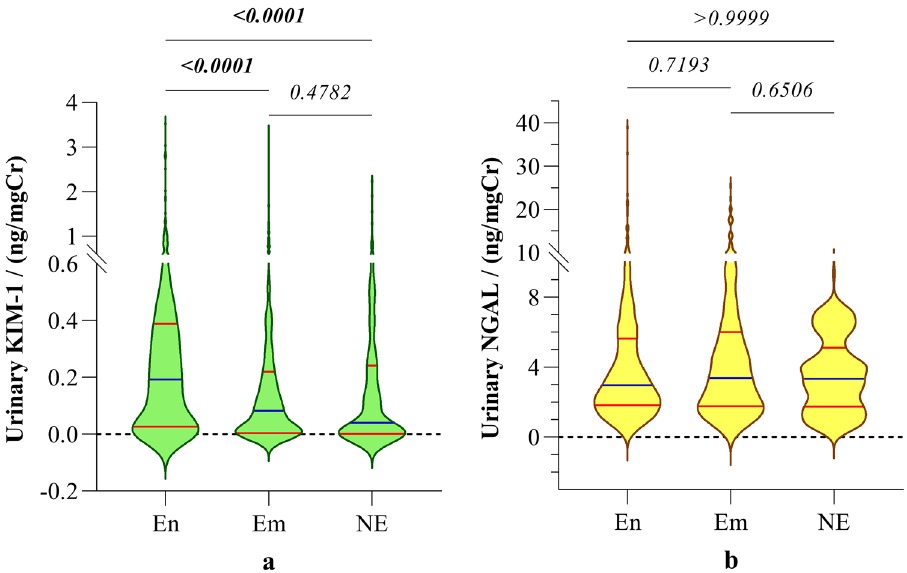
Figure 2. Distribution of urinary biomarkers ( a ) KIM-1 and ( b ) NGAL in children from CKDu endemic, emerging and non-endemic regions irrespective of gender. Graphs illustrate the median and interquartile range. Inter-group comparison is expressed in terms of Kruskal–Wallis one-way analysis followed by Dunn’s multiple comparison test. The study groups: En: endemic, Em: emerging and NE: non-endemic regions. KIM-1: Kidney injury molecule-1; NGAL: Neutrophil gelatinase-associated